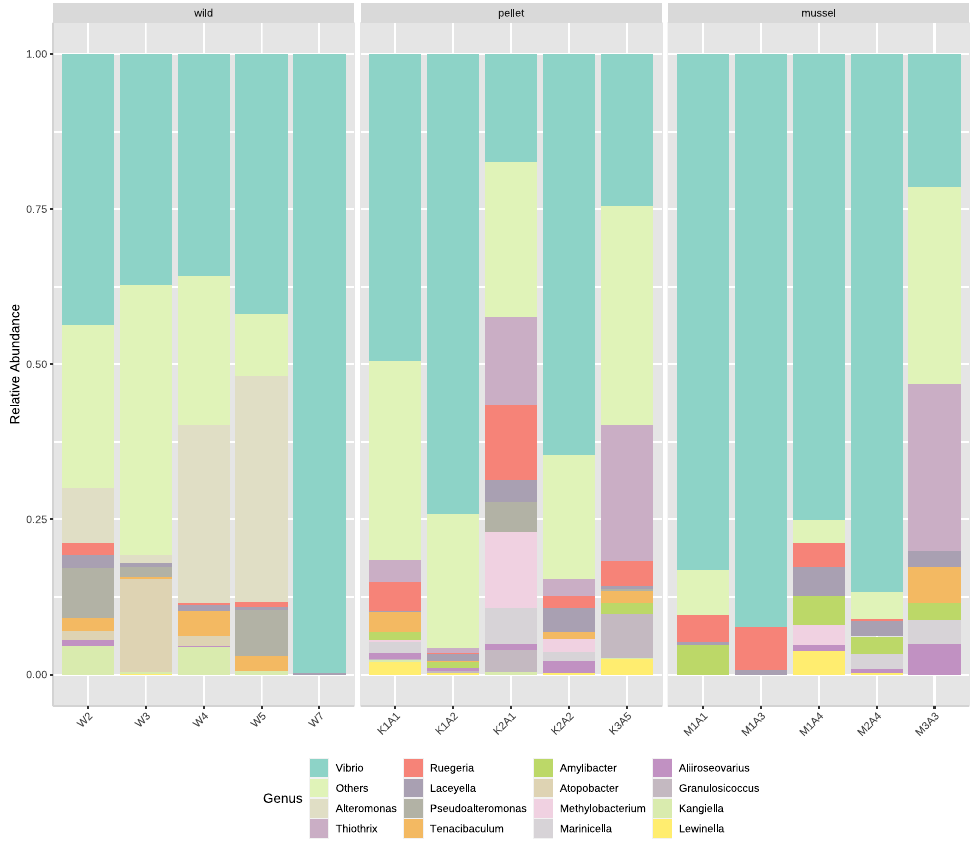
Figure 3. Relative abundance of bacterial features in the hepatopancreas libraries of juvenile P. ornatus at genus level.